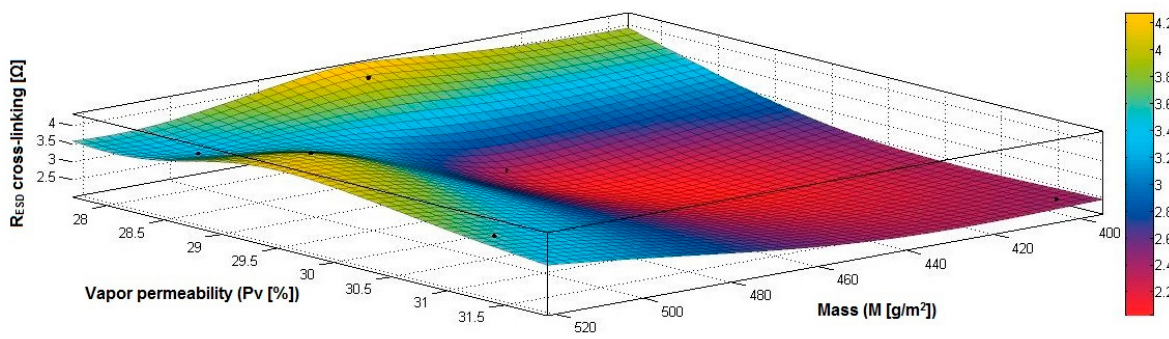
Figure 43. 3D representation R ESD after crosslinking = f(M, Pv) samples preliminarily treated in RF plasma O 2 using RF 2 generator and power 50 W.